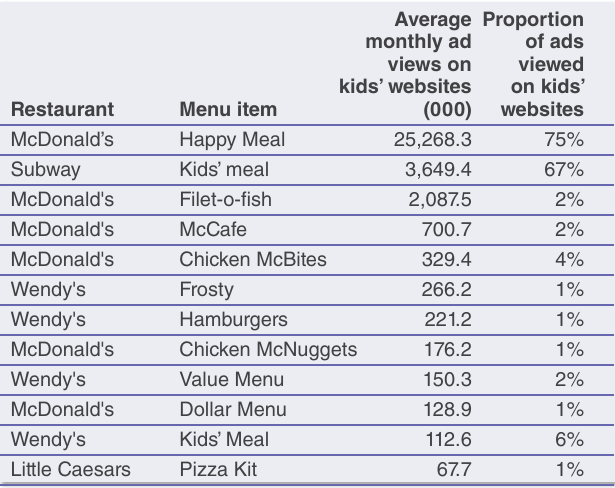
Table 29. Display ads viewed on kids’ websites by menu item